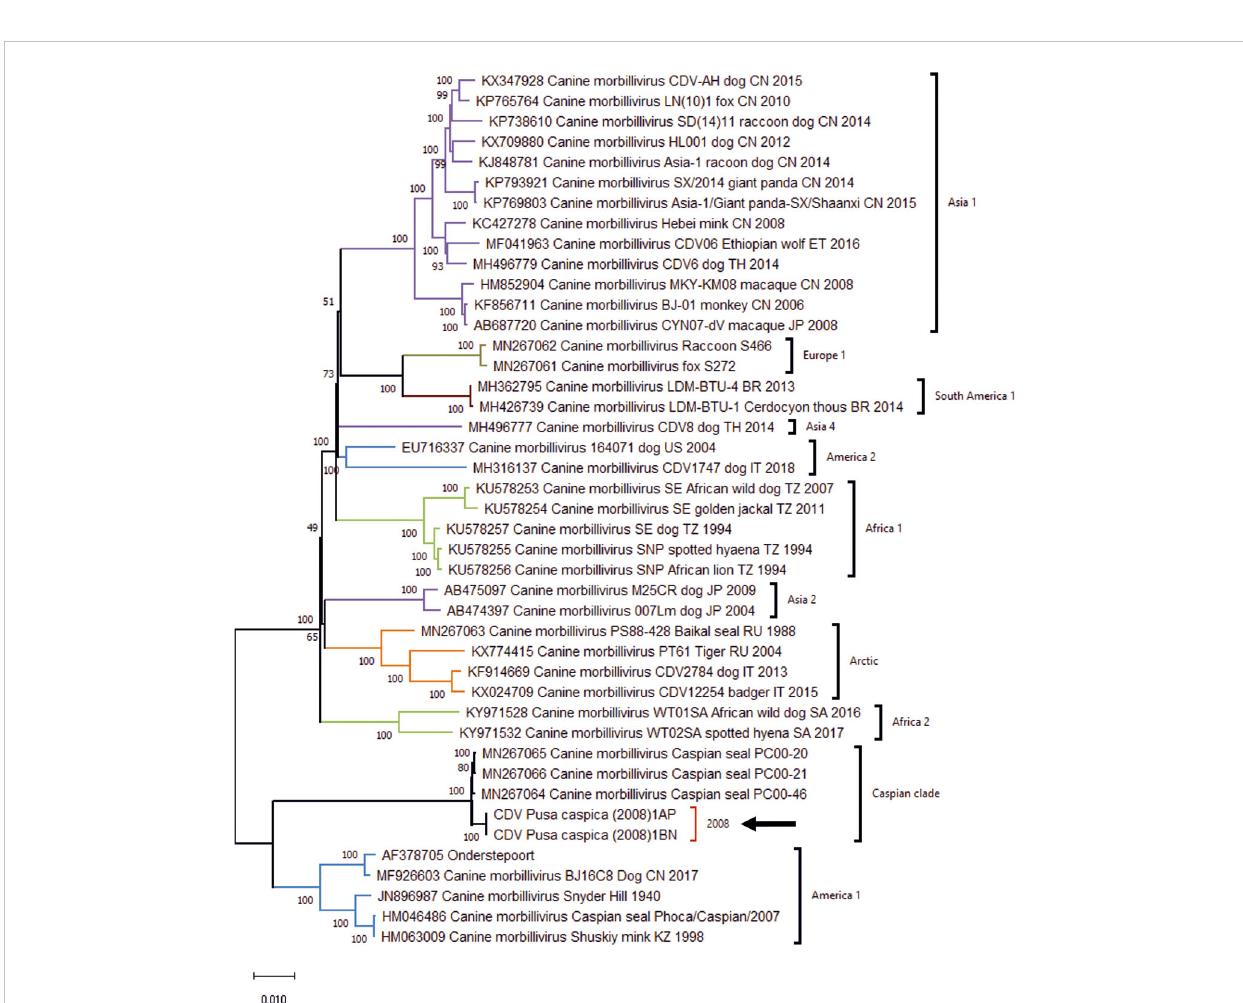
Bold text highlights positive results. Prevalence given as x/n, where x is number of samples testing positive, and n is total number of samples tested for each virus in each year. Single numbers indicate number tested with zero positives. CDV, Canine distemper virus; IAV, In fl uenza A virus; PhHV, Phocine